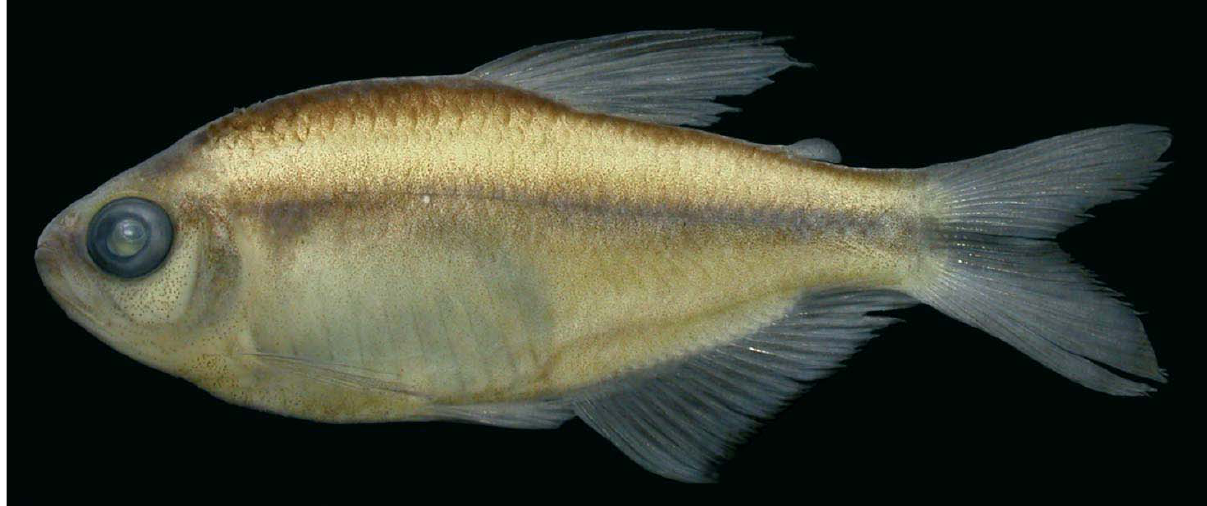
Fig. 4. Hyphessobrycon notidanos , MCP 39511, holotype, 28.6 mm SL; male, rio Doze de Outubro, tributary of rio Juruena, rio Tapajós basin, Mato Grosso, Brazil.